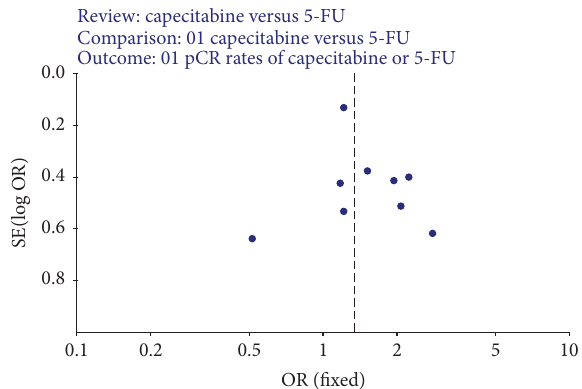
studies of advanced colorectal cancer [24]. Capecitabine mimics CIV 5-FU in its pharmacologic action in vivo; it has shown equivalent efficacy to CIV 5-FU plus leucovorin